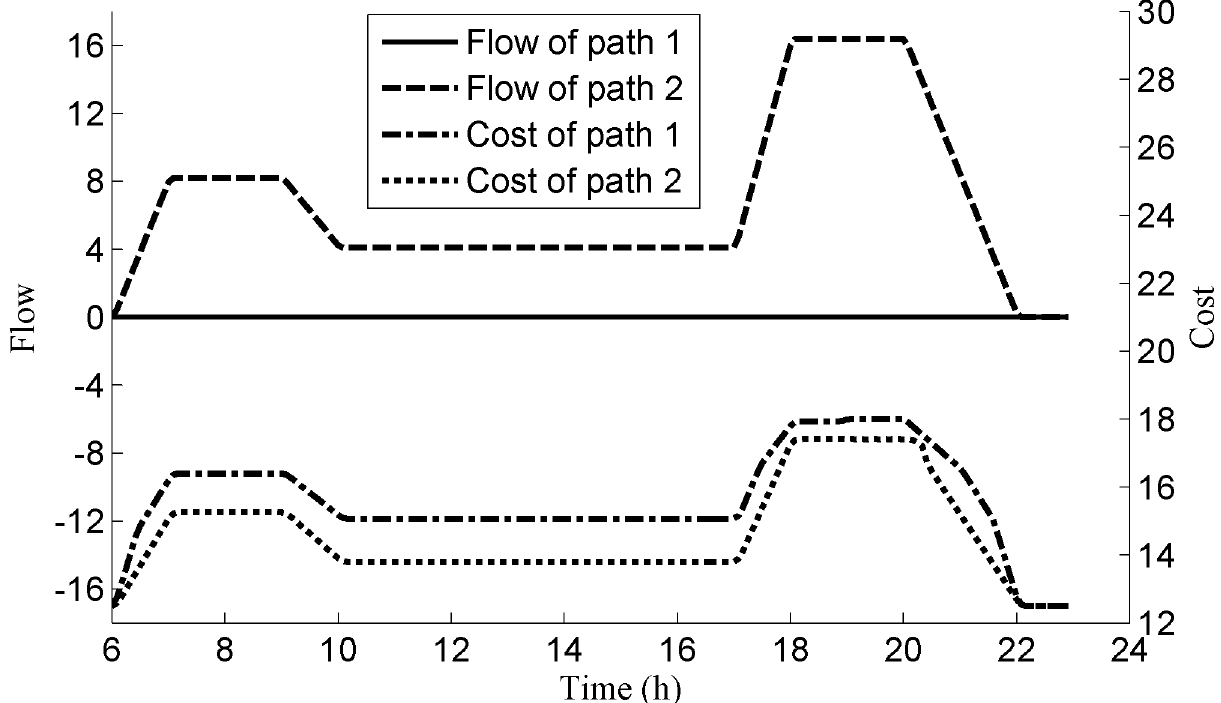
Fig 9. The flows and costs of two paths for passengers from platform s 2